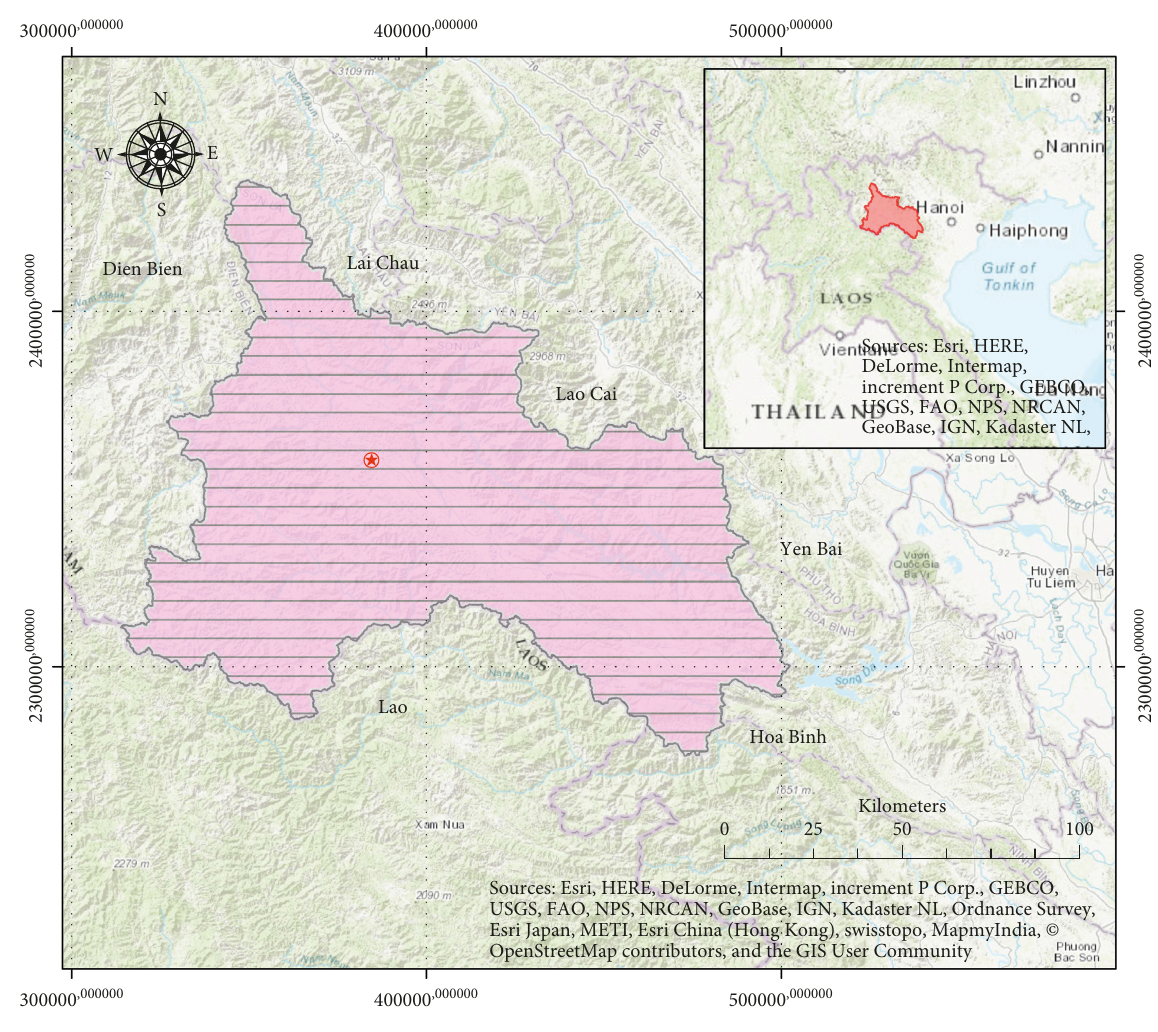
Figure 1: Location of Son La